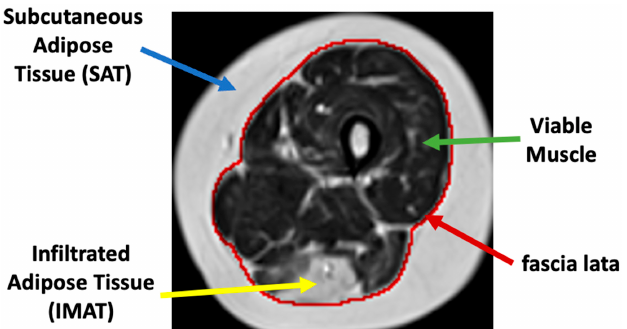
Figure 1. Axial MR image of the thigh. Red: fascia lata boundary; blue, green, and yellow arrows mark the subcutaneous fat, a region of viable muscle, and IMAT